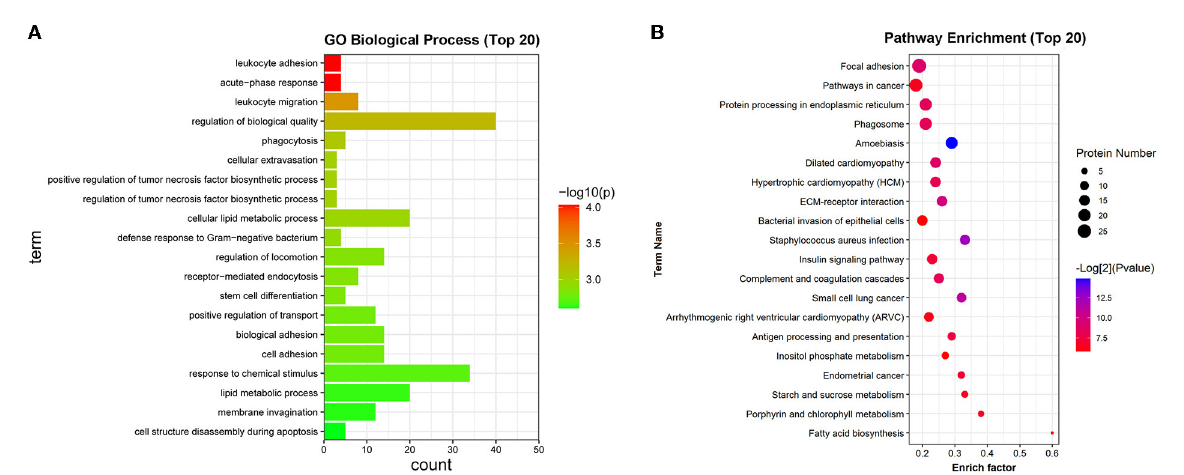
FIGURE4 GO and KEGG enrichment analysis of differentially expressed proteins. (A) The top 20 GO biological process terms that were significantly enriched by the differentially expressed proteins. (B) The top 20 KEGG pathways that were significantly enriched by the differentially expressed proteins.